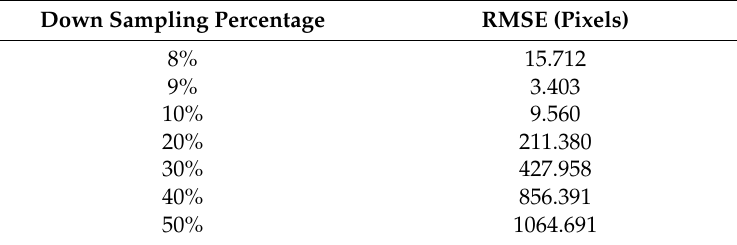
Table 2. RMSE of image registration varying with down sampling percentages.